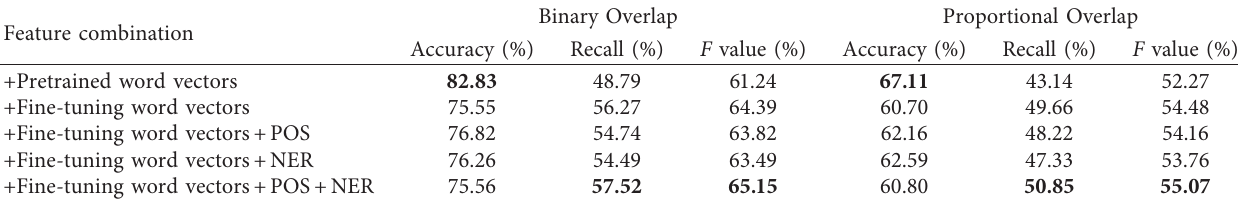
Table 3: Measurement of ESE recognition model under different feature combinations.